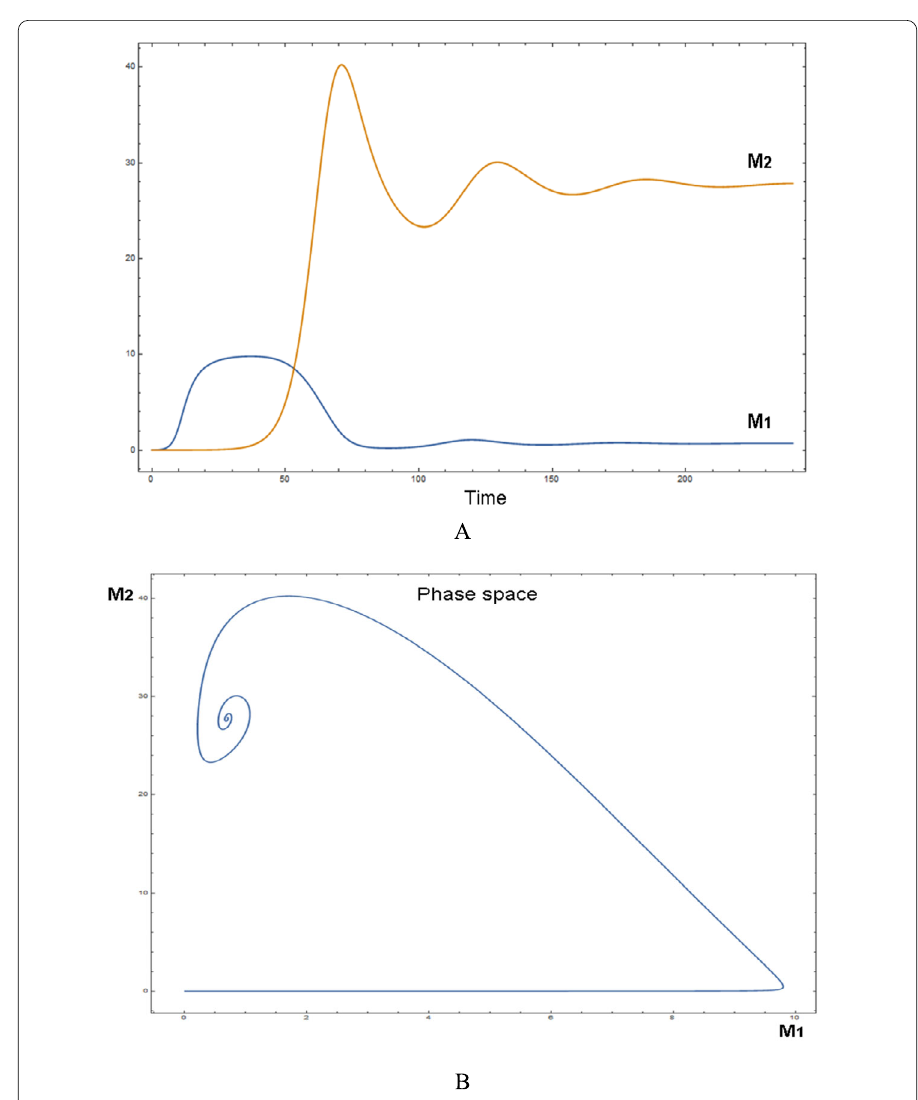
Figure 3 Time series showing local stability of the system at the steady state equilibrium neighborhood in A and the corresponding phase space in B for M 1 (0) = 0.01, M 2 (0) = 0.002, a 1 = 0.06, b 1 = 0.039, V = 10, a 2 = 0.023, b 2 = 0.06, a 3 = 0.3, n = 0.79, m =